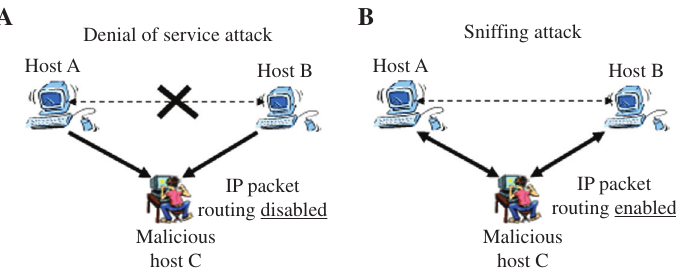
Figure 5. Biometric Data Sniffing Based on the MiM